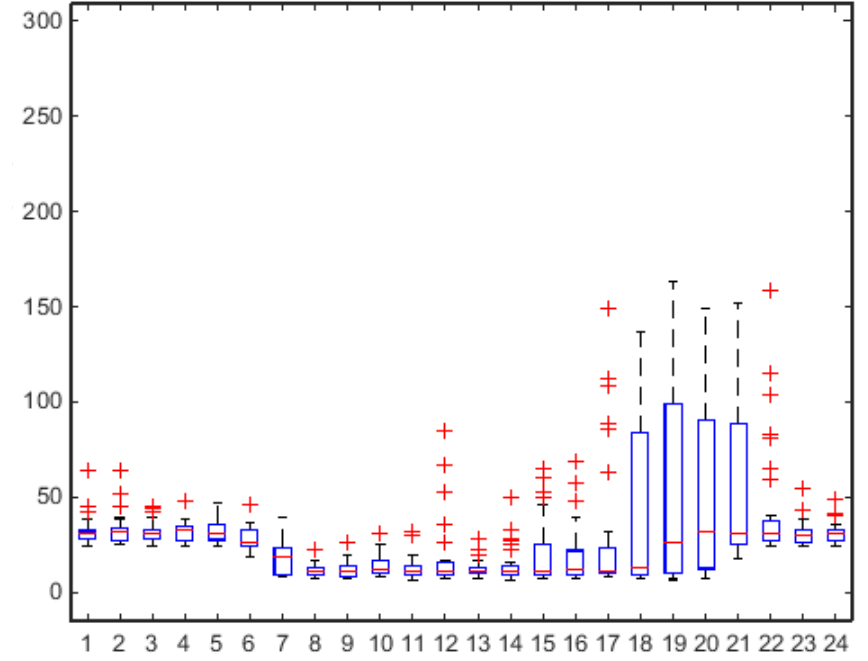
Figure 8. Pilot system: School (Palo del Colle). Box plots of working days power consumption. The x-axis reports day ours, while y-axis indicates power consumption